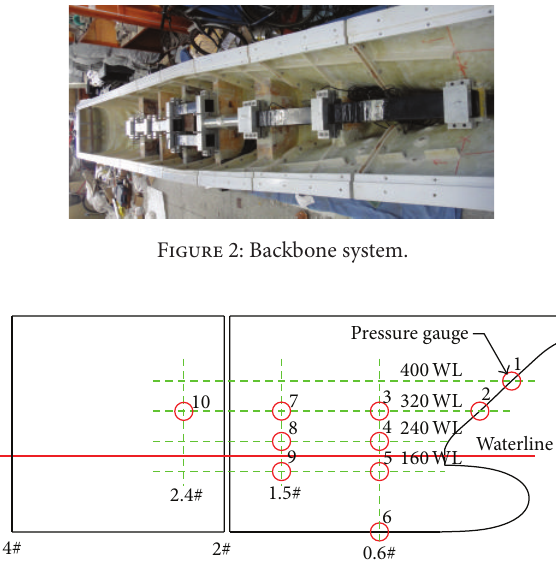
Figure 3: Pressure gauges